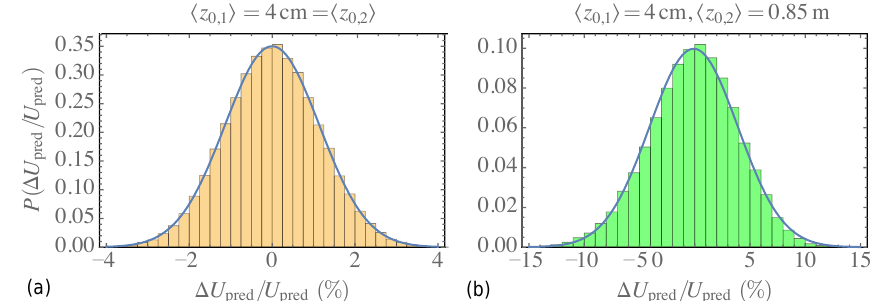
(cid:0) z (cid:104) z (cid:105) (cid:1) , and P (cid:0) z (cid:104) z (cid:105) (cid:1) at prediction and measure- 0 , 2 / 0 , 2 0 , 1 / 0 , 1